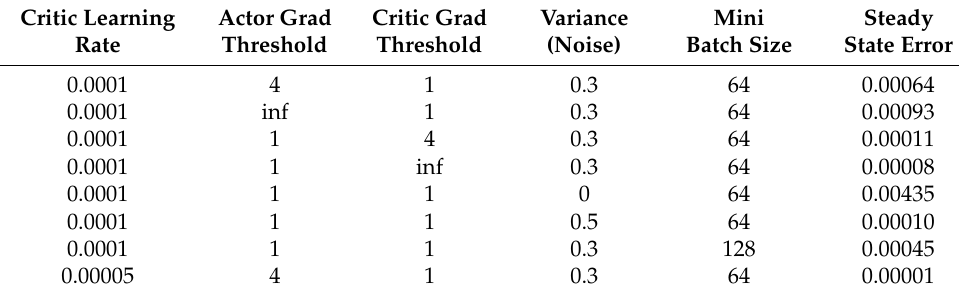
Figure 14. Variations in adaptive gain values of the Y position PID controller. Table 5. Variation of RL hyperparameters and their effect on the steady-state error.